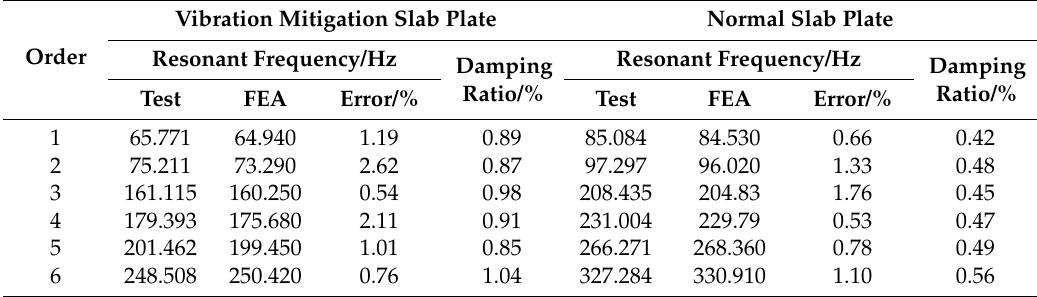
Table 3. Modal frequencies and damping ratio comparison.